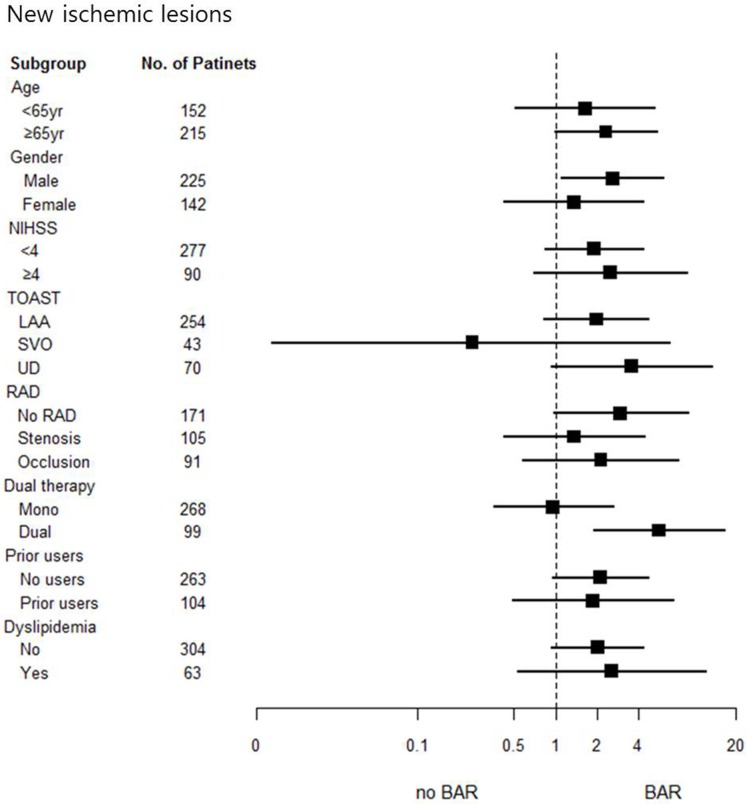
Subgroup analysis of NILs.A predefined secondary analysis for NILs on follow-up DWI showed that significant differences were present in the adjusted effect of BAR in patients who were male and had undergone dual therapy. Abbreviations: NILs, new ischemic lesions; RAD, relevant arterial diseases.